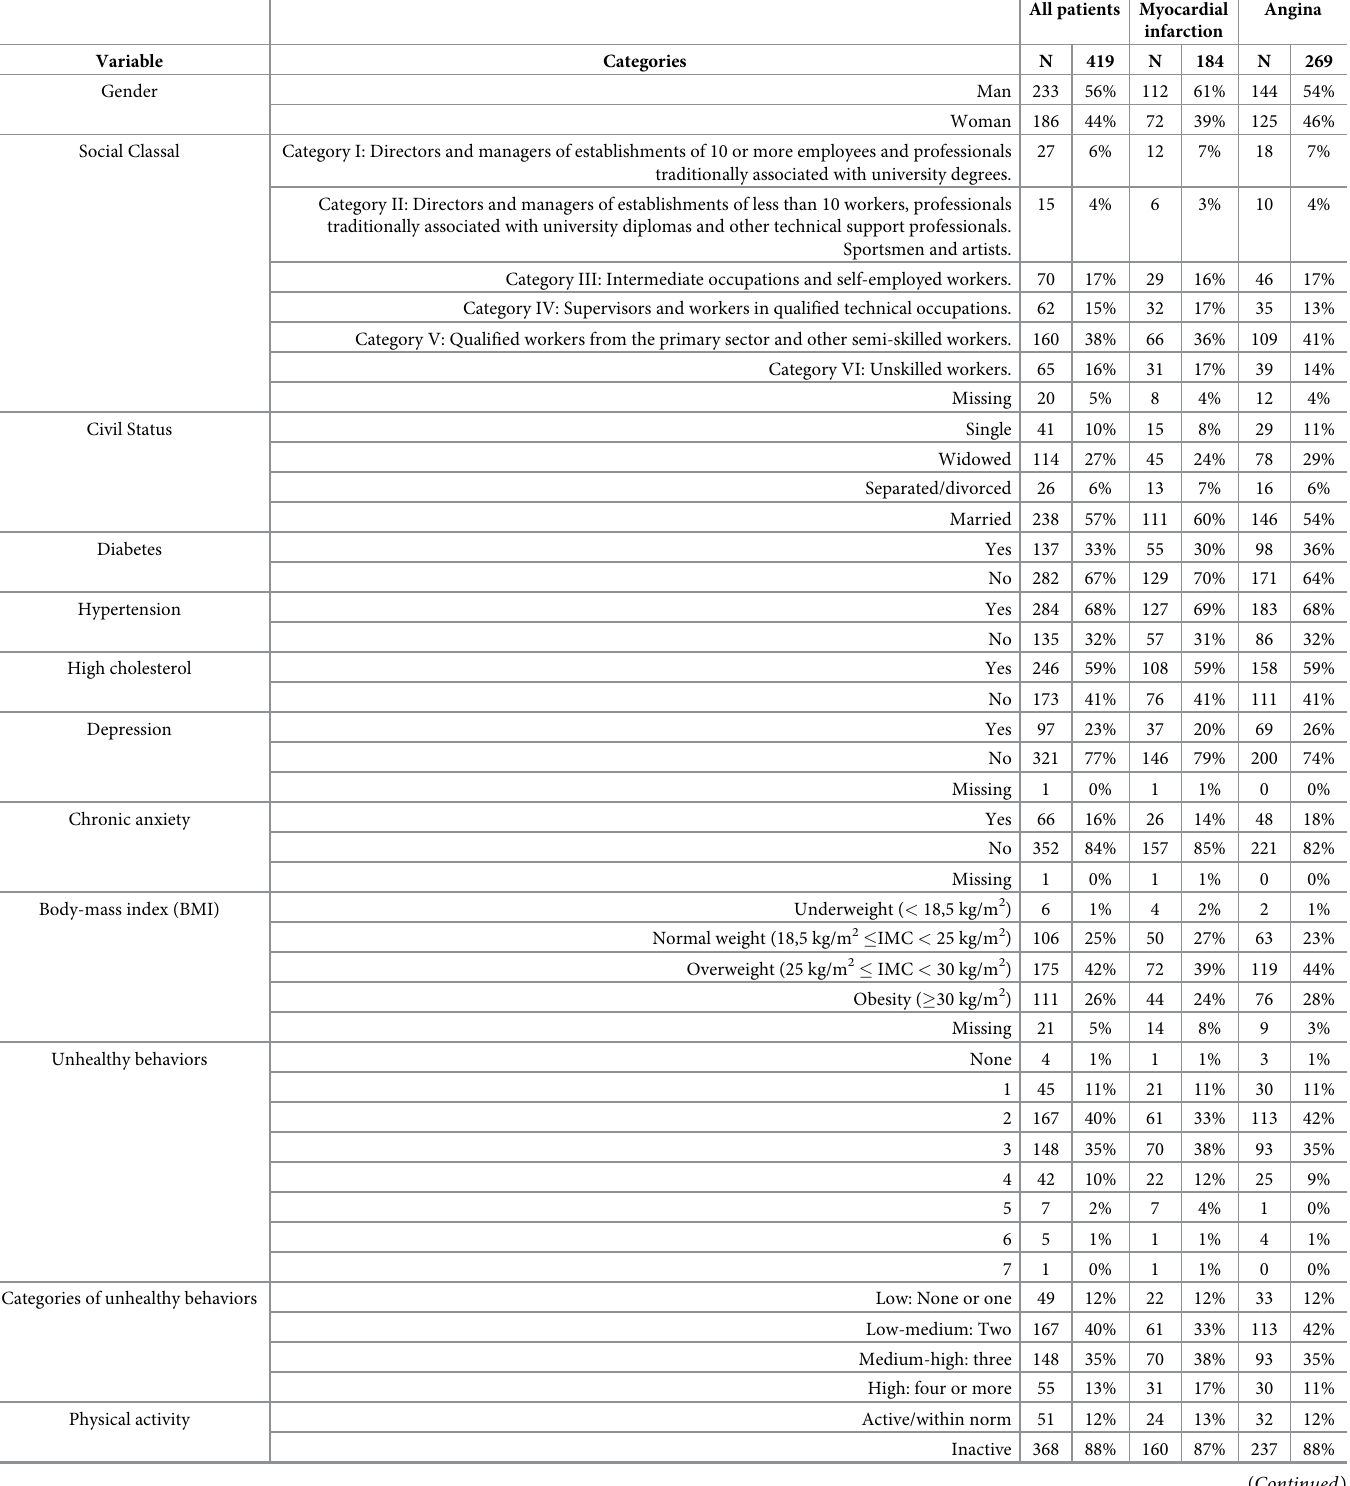
Table 1. Descriptive statistics (number of cases and percentage from total) for categorical variables used in the study.